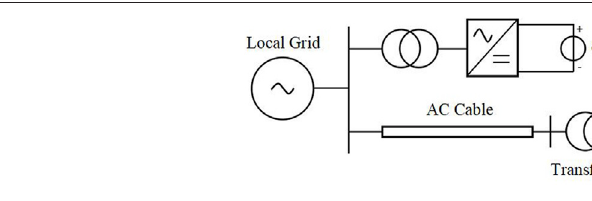
TABLE 1 | Key parameters of the study